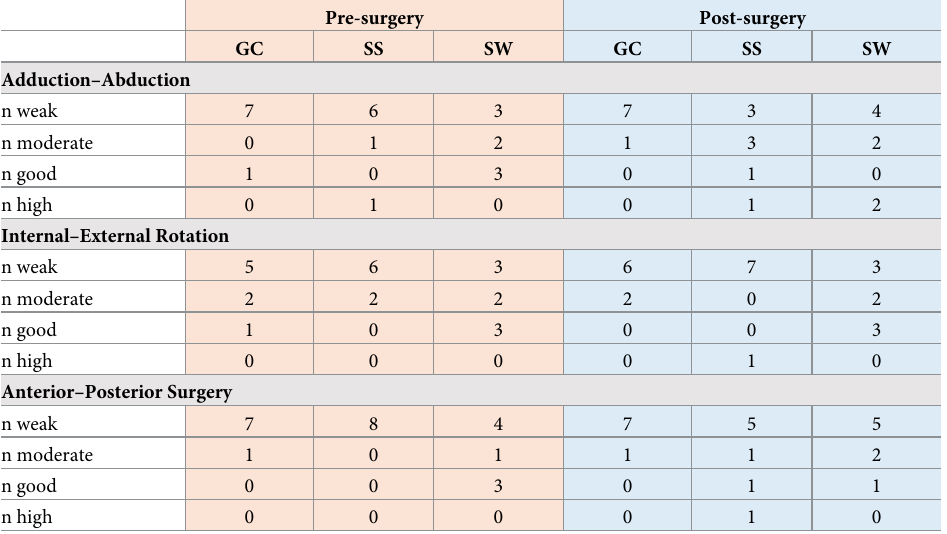
Table 3. Number of patients in each category of R 2 for each degrees of freedom and for the whole gait cycle (GC), the single stance phase (SS) and the swing phase (SW) before and after